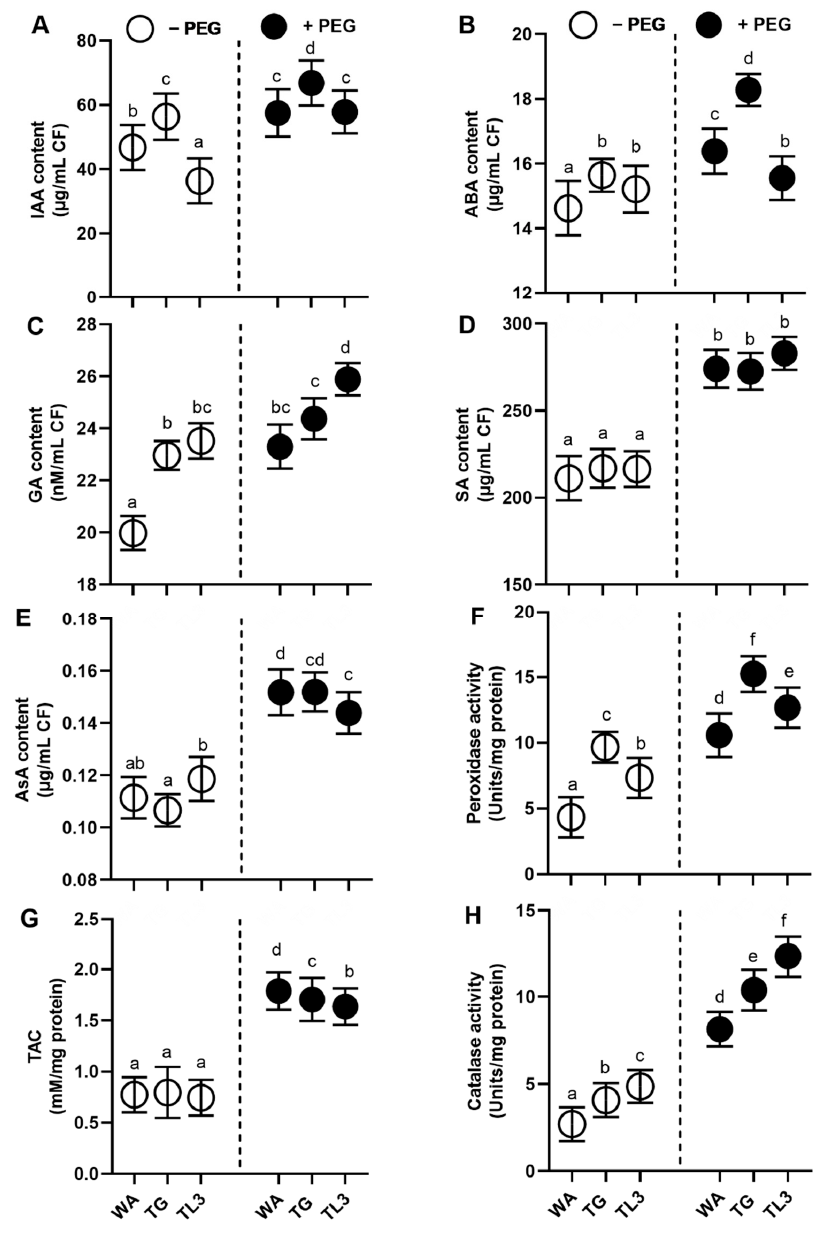
Figure 3. Hormonal contents in CF. ( A ) IAA content, ( B ) ABA content, ( C ) GA content, and ( D ) SA content. Enzymatic and non-enzymatic antioxidants in CF. ( E ) AsA content, ( F ) peroxidase activity, ( G ) total antioxidant capacity, and ( H ) catalase activity. Quantitative data represent means ± SE of three independent biological replicates presented with various letters showing differences at a significance level of p ≤ 0.05 using Duncan’s multiple range test (DMRT). CF: culture filtrate. 3.6. Quantification of H 2 O 2 and Antioxidants in Culture Filtrate under Drought Stress WA, TG, and TL3 isolates also ably produced antioxidant enzymes with stronger antioxidant capacity, under PEG-induced drought stress (Figure 3). By supplementing